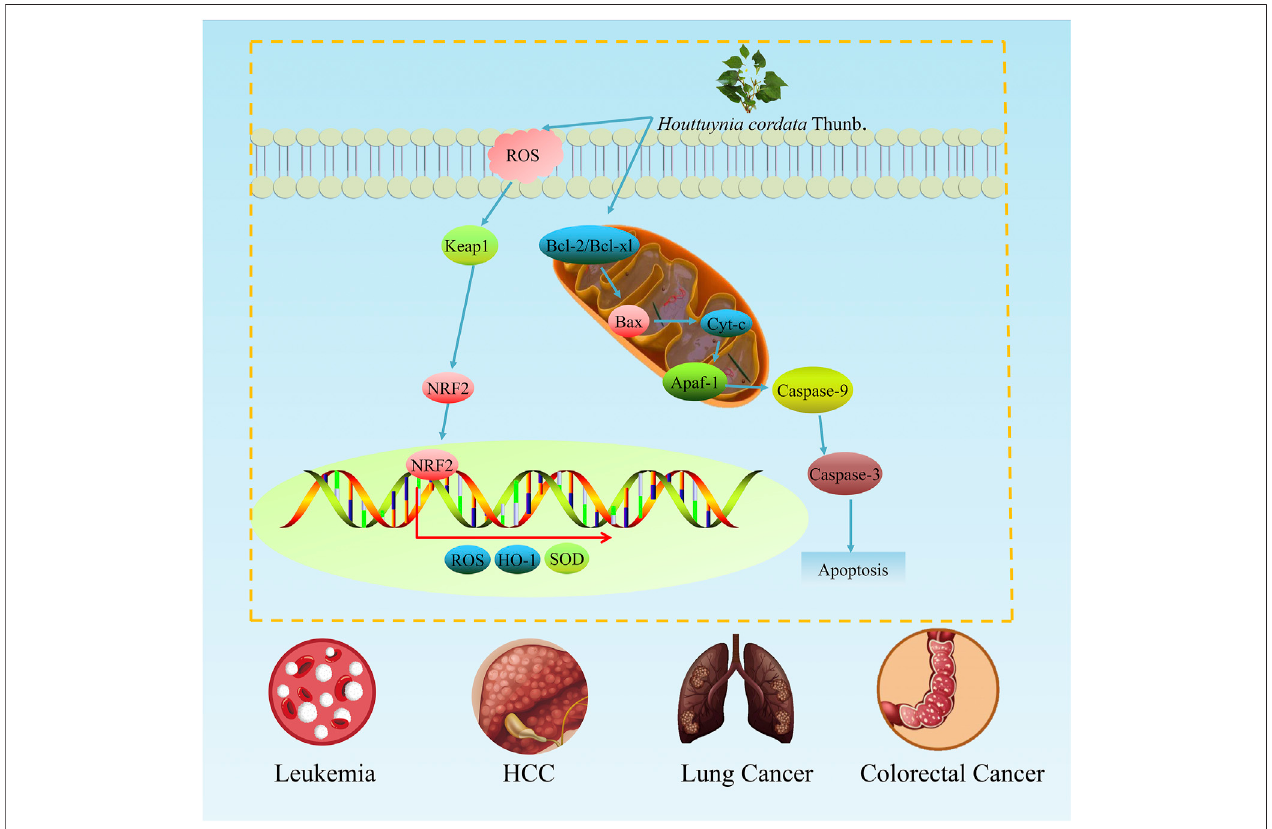
FIGURE 3 | The antitumour effects of H. cordata. H. cordata might suppress multiple tumours mainly by inhibiting the NRF2 signalling pathway and promoting the process of apoptosis.